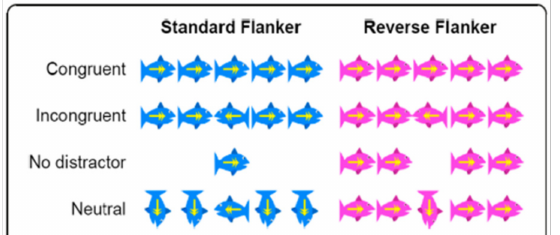
Figure 1. Examples of the stimuli in the modified Flanker test of executive functions showing blue fish’s: Standard flanker test (target stimulus = middle fish) and pink fish’s: Reverse flanker test (target stimulus = ‘non-middle’ fish). Borrowed from Have et al.